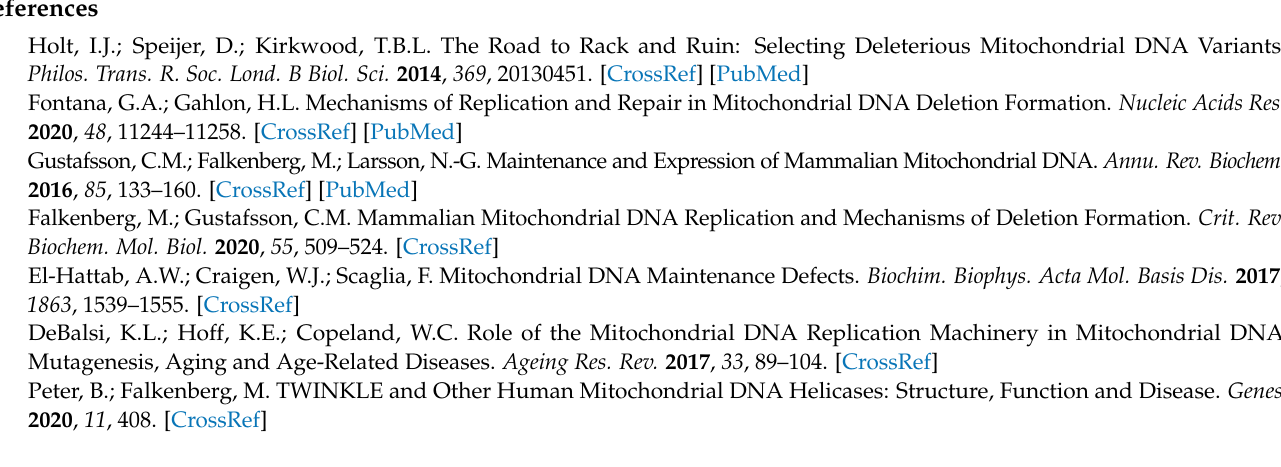
library; Figure S1: Impact of APE1inhIII on mtDNA maintainance; Figure S2: Knockdown efficiency; Figure S3: Del3895 formation after ENDOG or POLGA knockdown; Figure S4: Effect of mtDNA replication inhibition; Figure S5: POLZ localizes to mitochondria; Figure S6: POLZ level depends on ROS; Figure S7: POLZ depeletion reduces mitochondrial